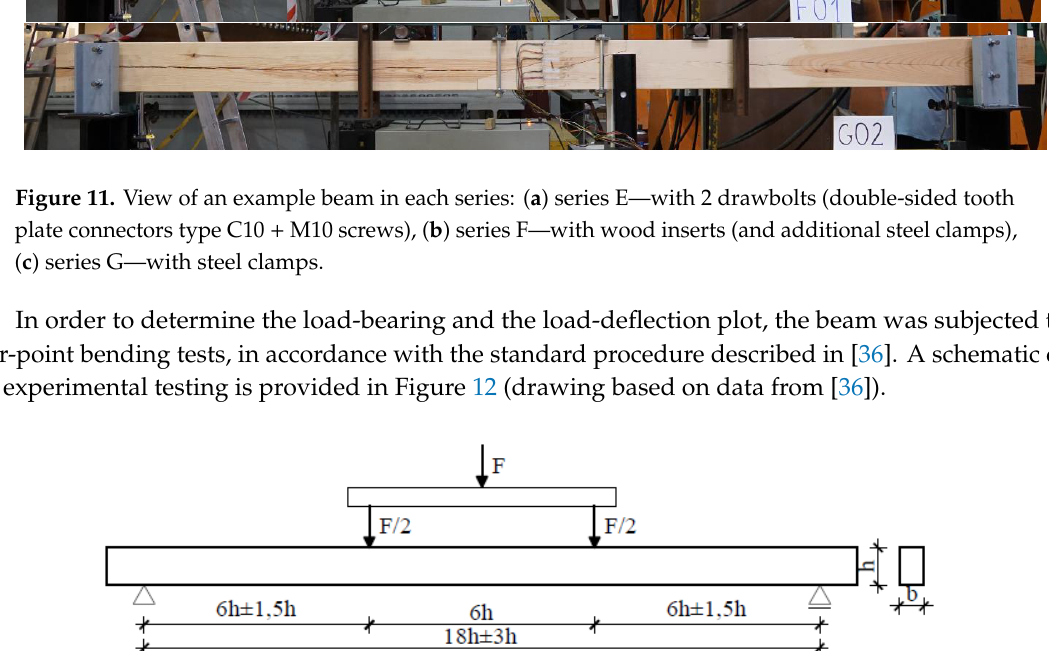
Figure 12. Scheme of the four-point bending test in accordance with standard procedure.